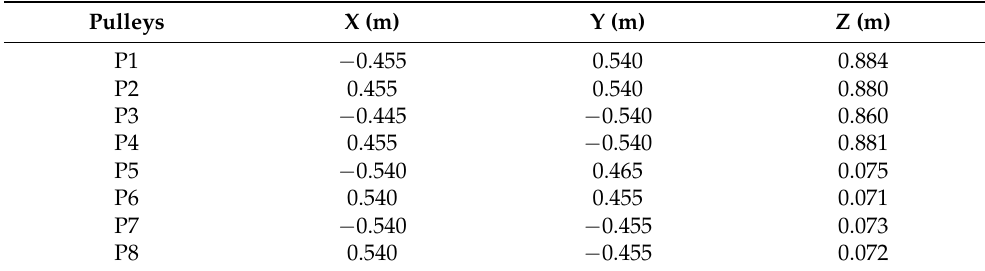
Table 1. Coordinates of the